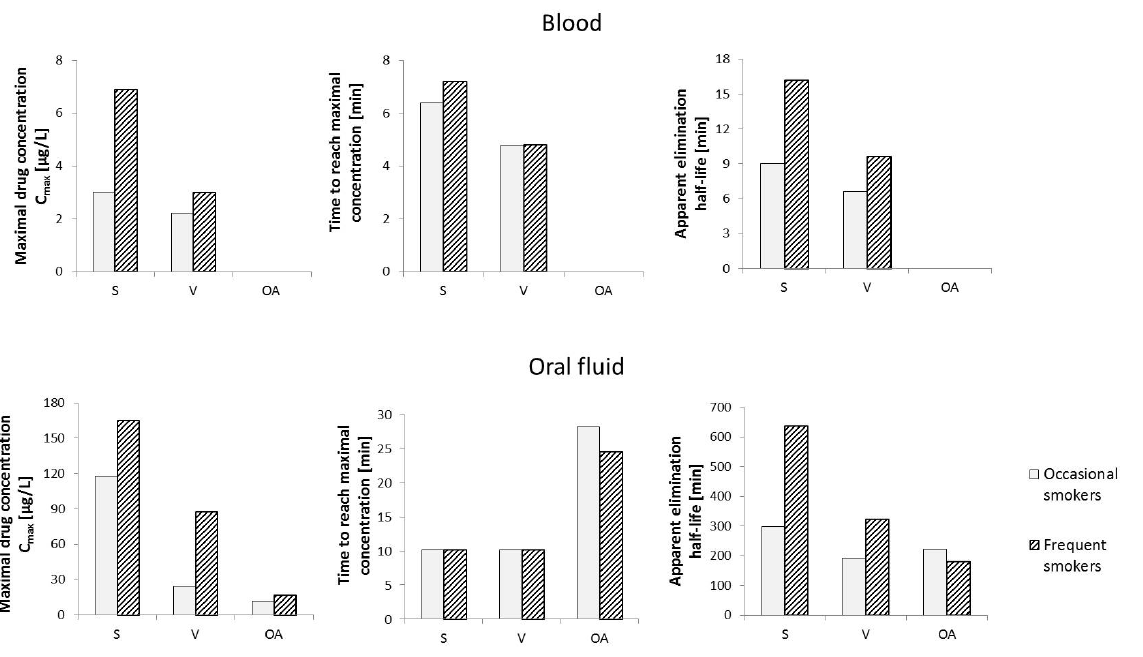
Figure 6. Changes in cannabigerol levels in human blood and oral fluid over time depending on the route of administration of Cannabis sativa L. Abbreviation: S—smoking, V—vaporization, OA—oral administration [74,75].